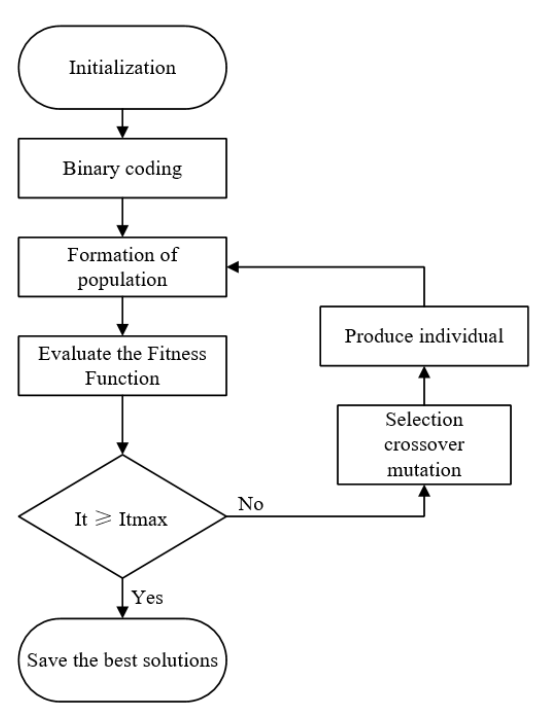
Figure 6. Structure of the GA to optimize fuzzy PID.